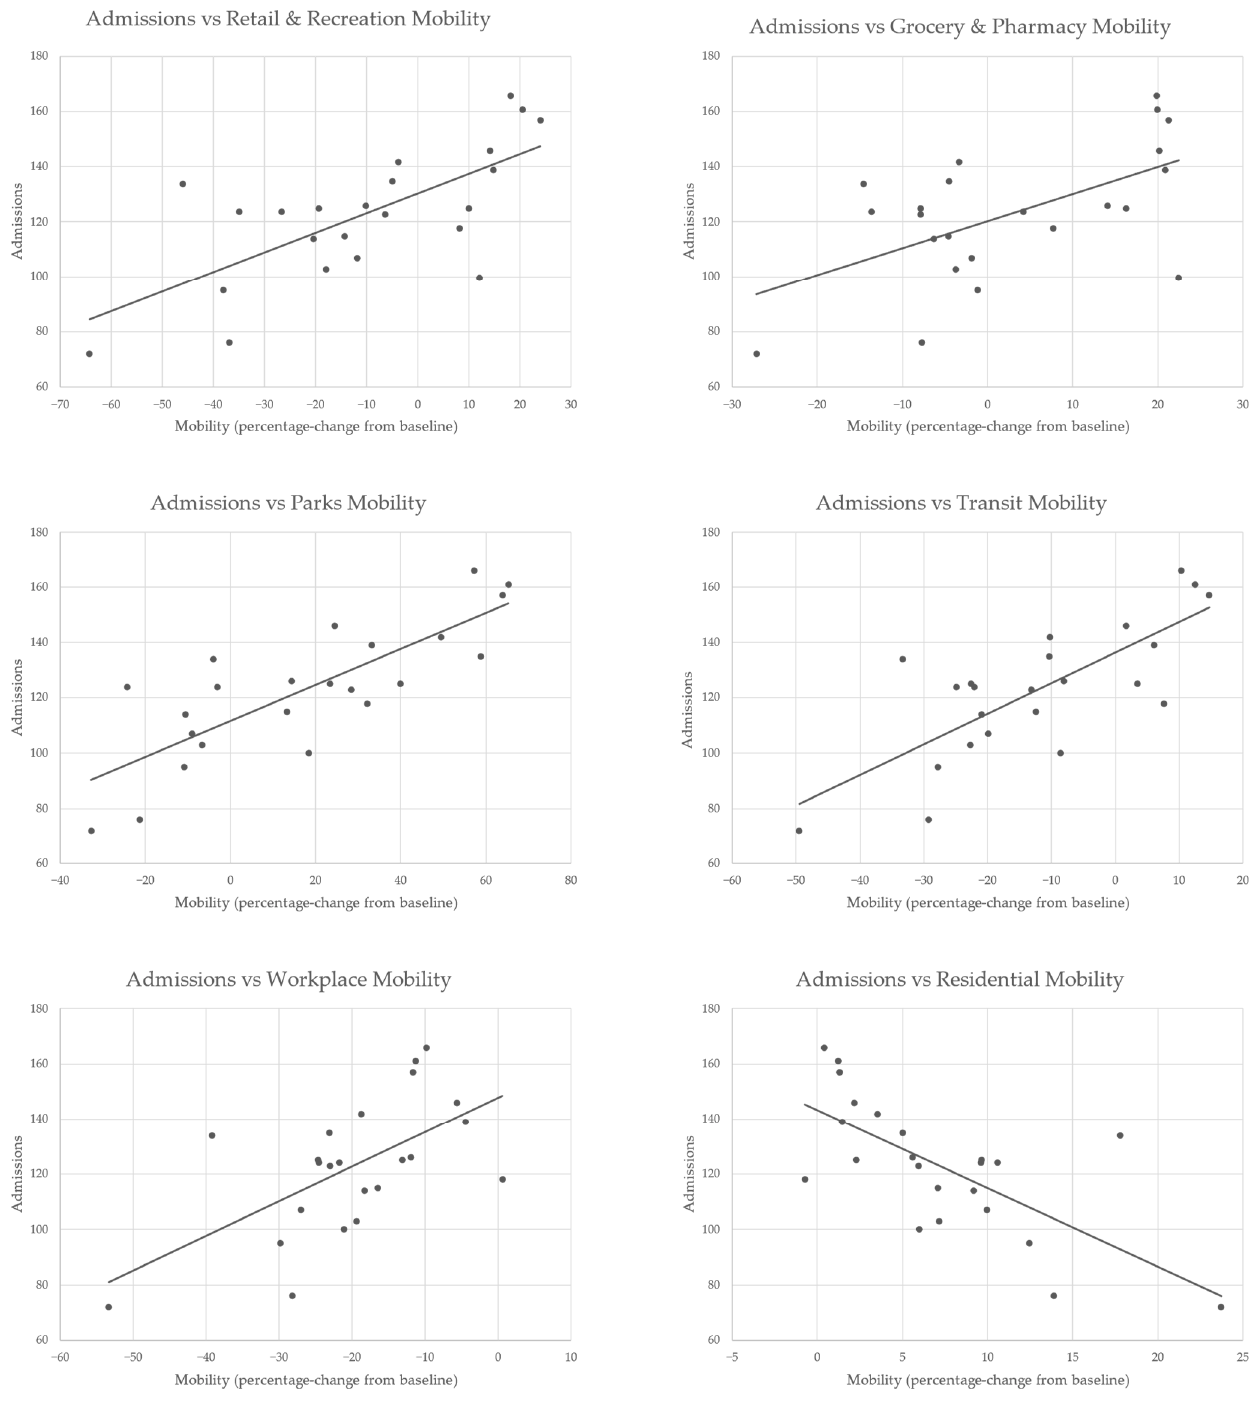
Figure 2. Scatter plots with lines of best fit for total monthly admissions vs. Community Mobility Reports for Malta.